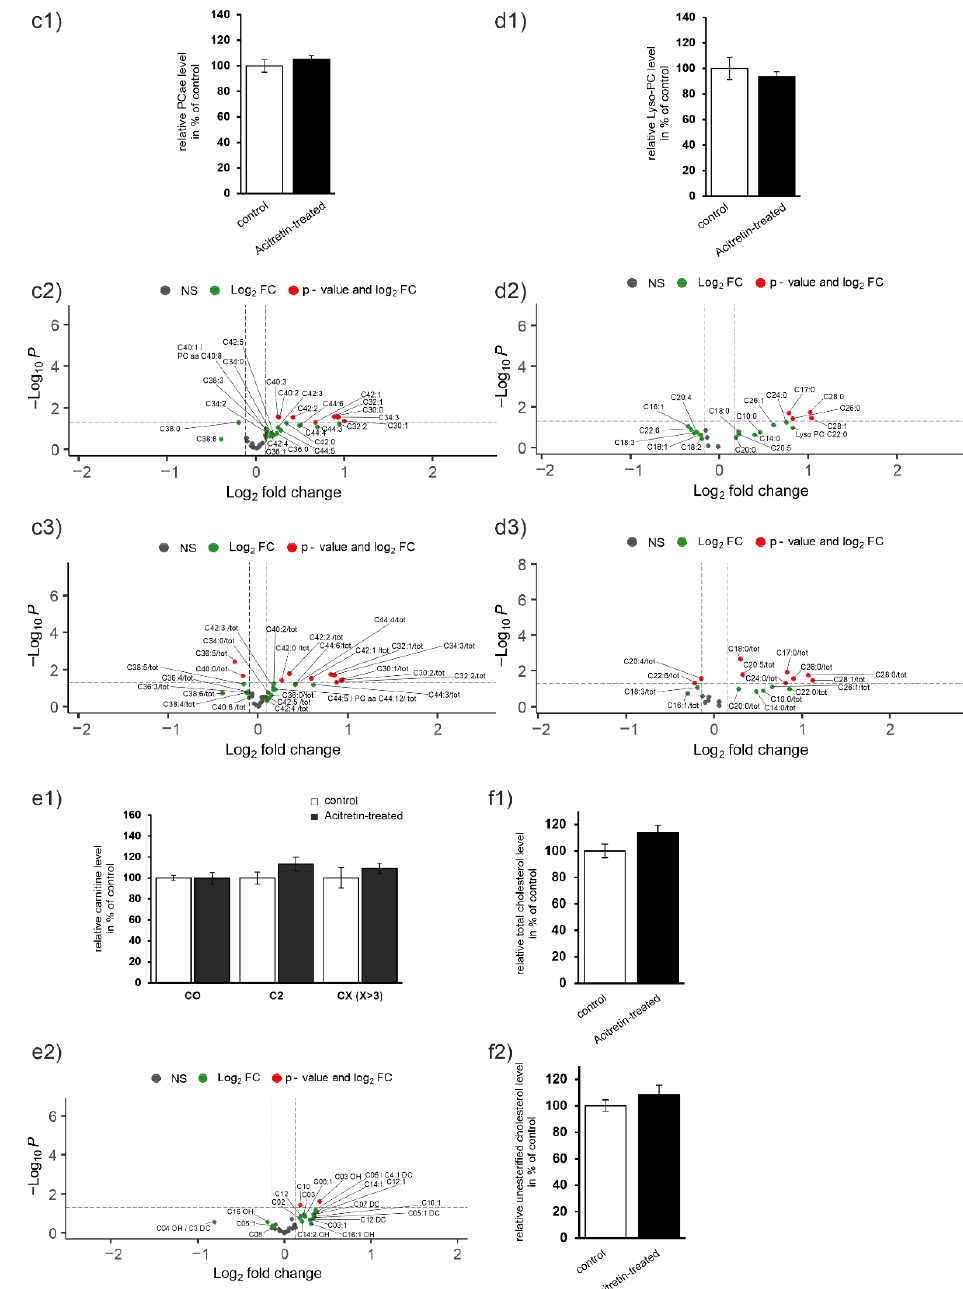
Figure 3. Lipid species in hepatic tissue. Mice were treated as described (Figure 1) and lipids from liver lobes extracted by combination of mechanical and chemical treatments. Lipid species were identified by mass spectrometry: ( a ) triacylglycerides (TAG), ( b ) phosphatidylcholine (PC aa), ( c ) plasmalogens (PC ae), ( d ) lyso-PC, ( e ) carnitines (1: relative change of groups; 2: individual carnitines), and ( f ) total cholesterol ( f1 ) and unesterified cholesterol ( f2 ). Sphingomyelins (SM) can be found in Supplementary Figure S2 and effect sizes for all significantly affected species in Supplementary Figure S3. Subfigures a1 – d1 display change in % of the whole lipid class. Figures a2 – d2 show individual lipids and a3 – d3 individual lipids normalized to the whole lipid class. Statistical significance of the mean in liver tissue of acitretin-treated compared to control mice was calculated using two-sample t-test (n = 6 animals per group).